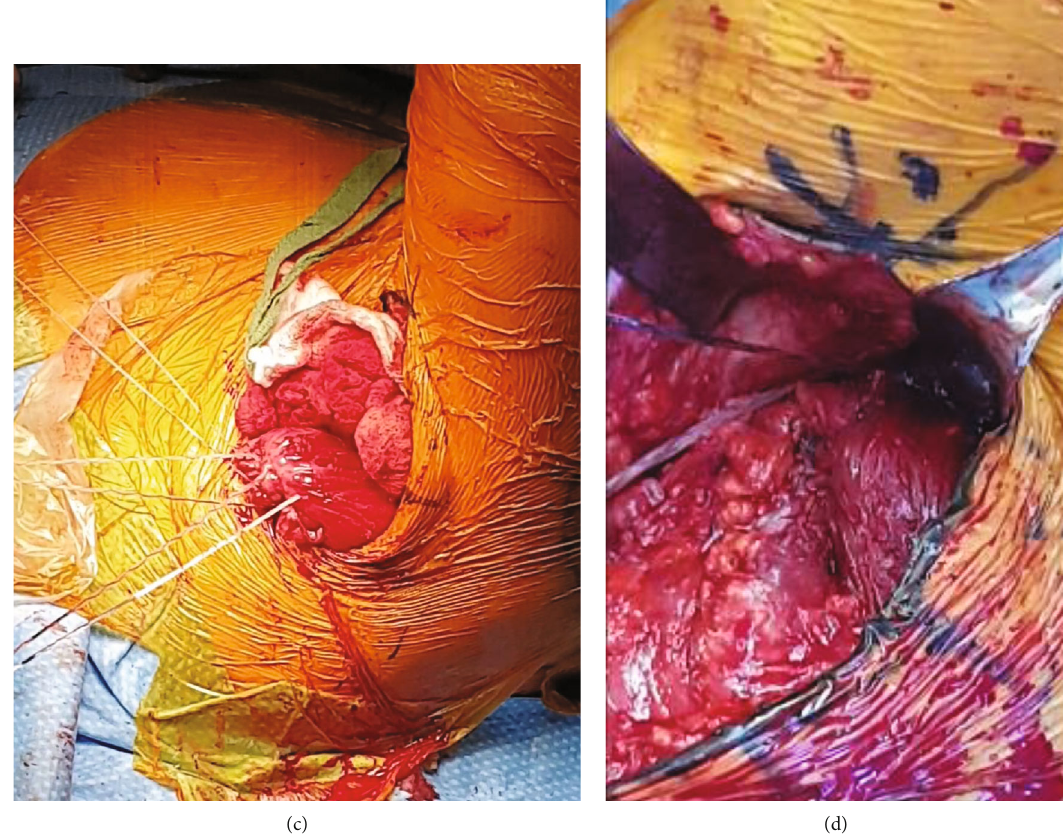
Figure 2: Edema and fl uid are noted along the medial aspect of the proximal humerus, originating near the medial margin of the distal bicipital groove. There is a full-thickness, retracted tear of the latissimus dorsi humeral attachment, with retraction of tendon fi bers approximately 2.5cm medially and 2cm distally. The teres major humeral attachment shows irregularity along its inferior margin (a). Intraoperative pictures demonstrating the torn latissimus dorsi (right arrow) and teres major (left arrow) tendons after adequate mobilization (b). The two tendon ends were secured together in a conjoint fashion using high-strength nonresorbable sutures in a Krackow fashion (c). The footprint was prepared, and sutures were passed through the cortical button and inserted into the medullary canal via unicortical drill holes. The tendon was reduced to the footprint using the sliding suture technique